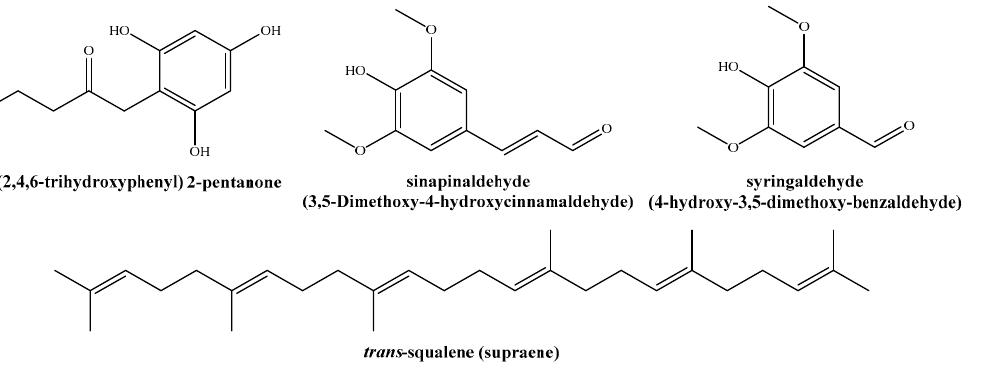
Figure 2. Main phytochemicals identified in the aqueous ammonia extract of T. gallica bark.